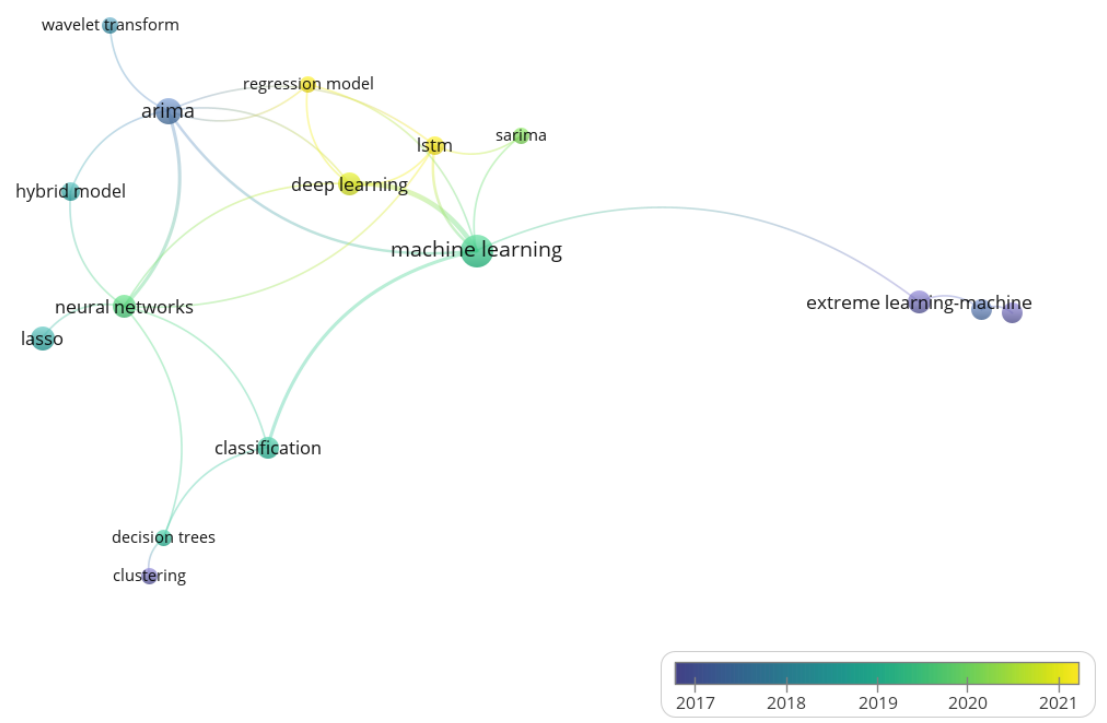
Figure 7. Bibliometric map of keywords in the overlay visualization context, co-occurrences (minimum 2) results from WoS based on Query 2. Source: Authors’ elaboration performed in the VOSviewer (version 1.6.18).